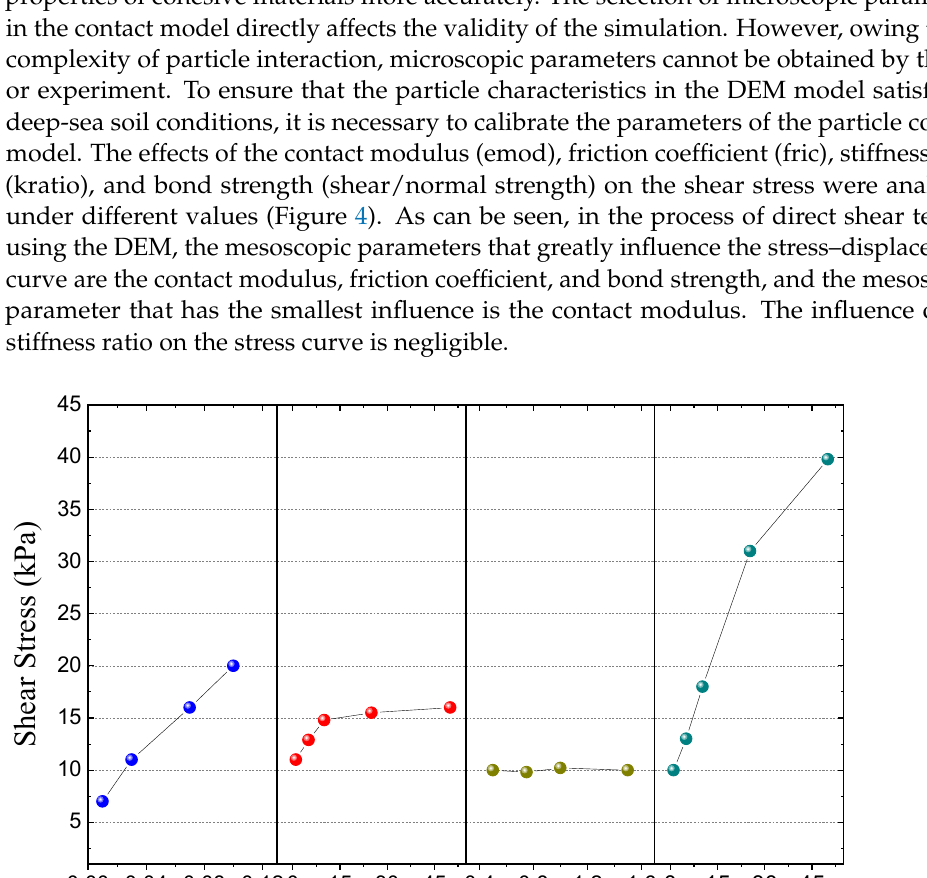
Figure 3. DEM direct shear model.